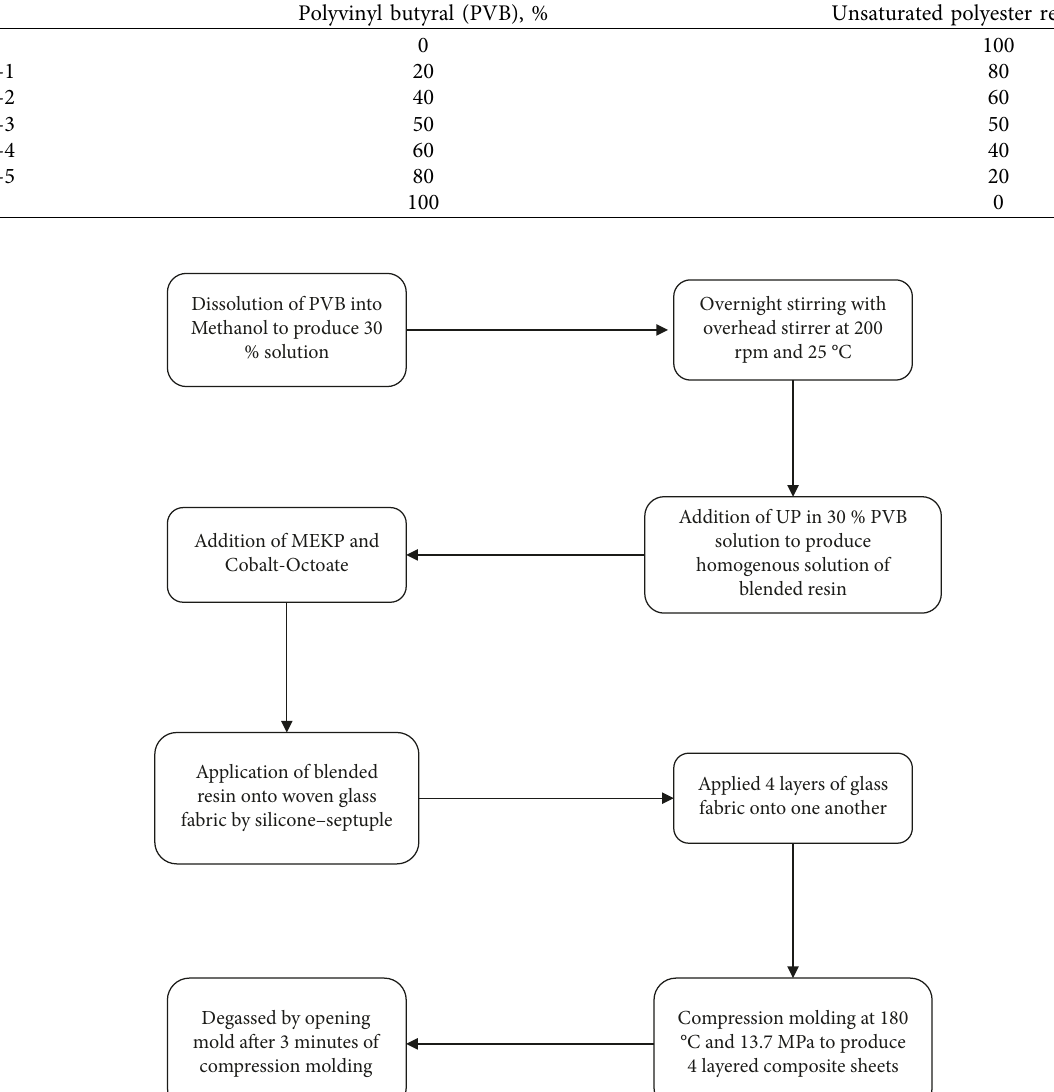
Table 1: Details of samples of the blend of PVB and UP.